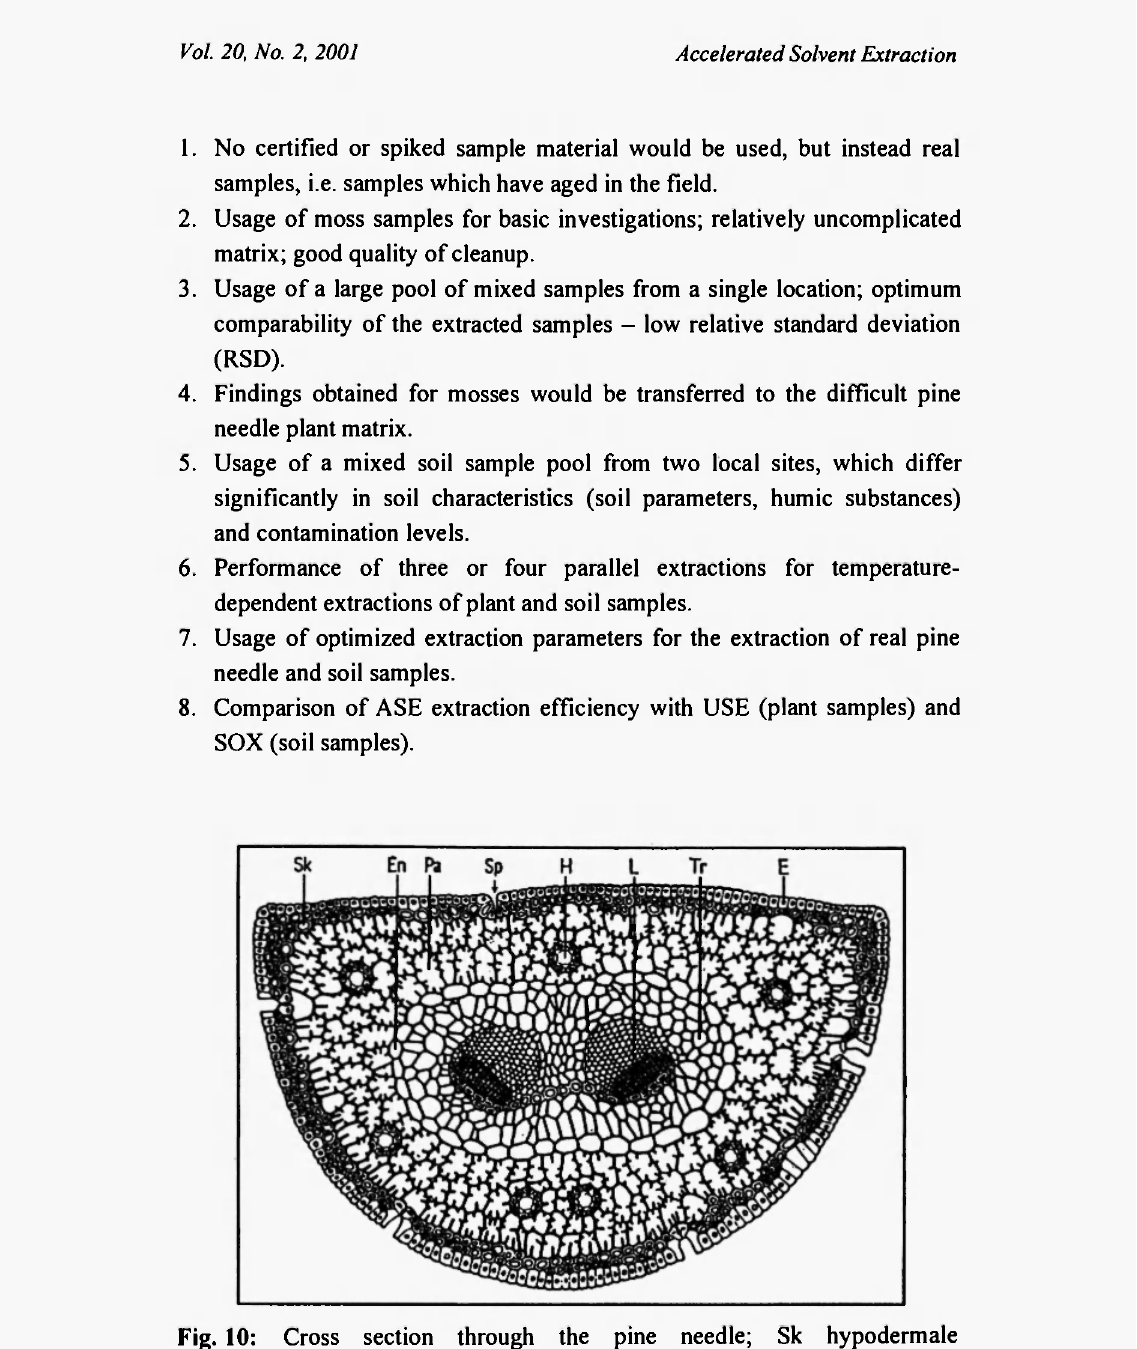
Fig. 10: Cross section through the pine needle; Sk